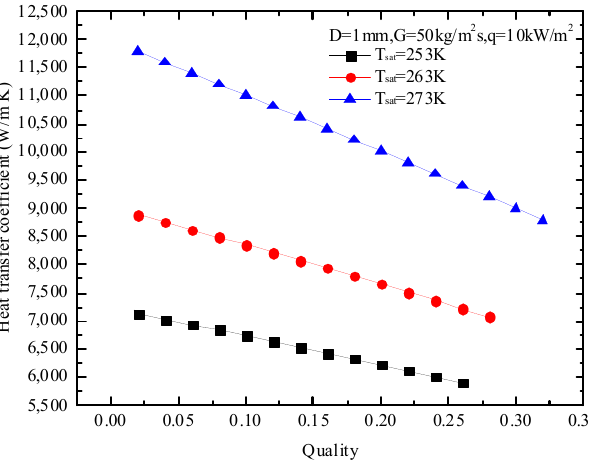
Figure 15. Effect of T sat on heat transfer coefficient of azeotropic refrigerant.